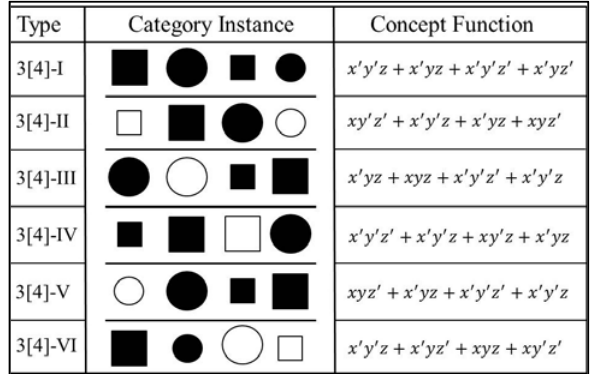
Figure 1. Six types of structures for sets consisting of objects defined over three dimensions (color, shape, and size). The last column consists of logical descriptions of the